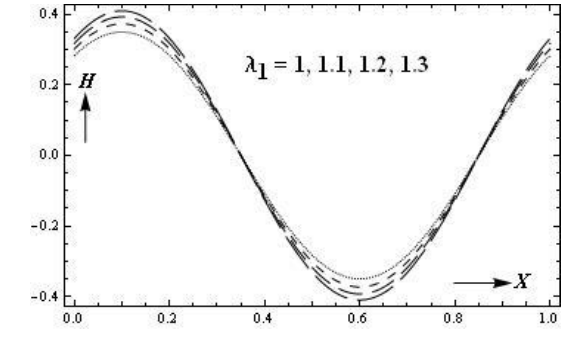
Figure 10 . Heat transfer coefficient for various values of Darcy number.